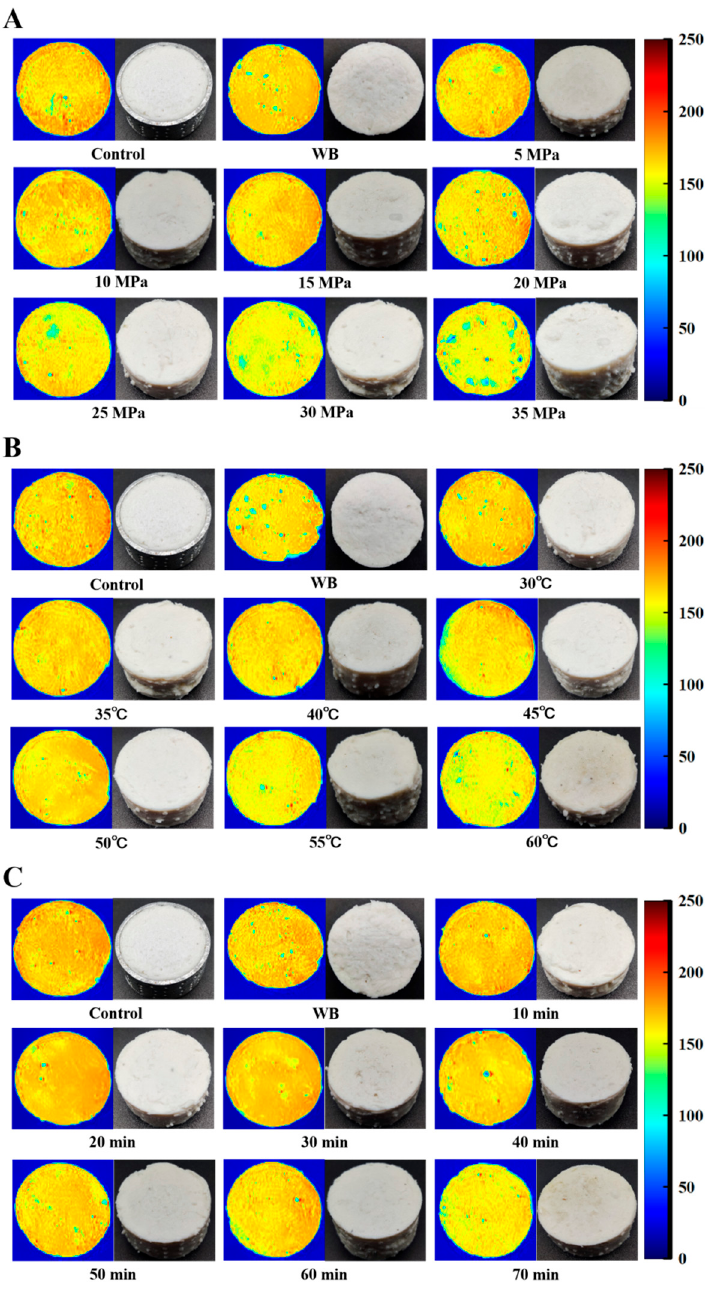
Figure 6. Effect of different DPCD treatments on MRI of surimi ( A ): Pressure, ( B ): Temperature, ( C ): Time.